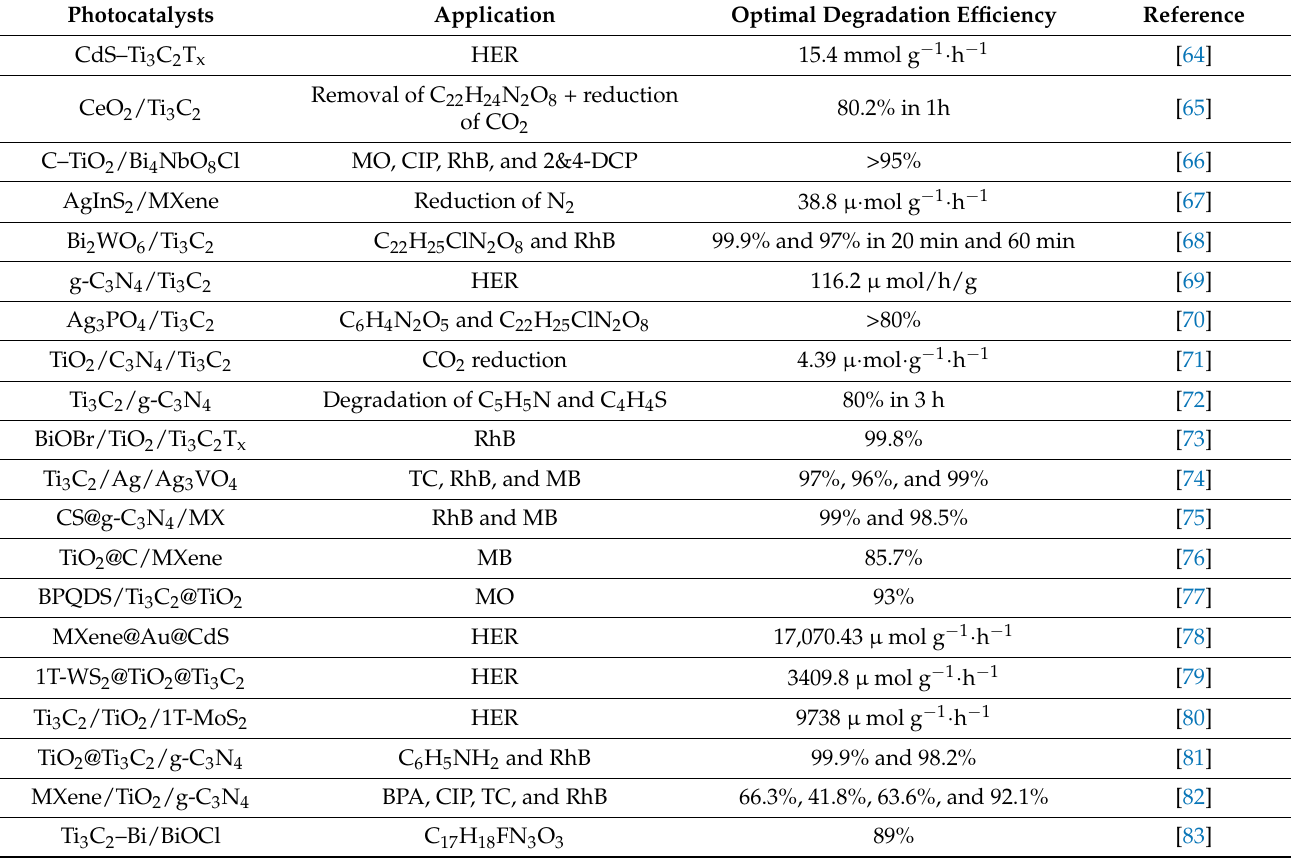
Table 1. Performance of degradation of pharmaceutical wastes from MXene